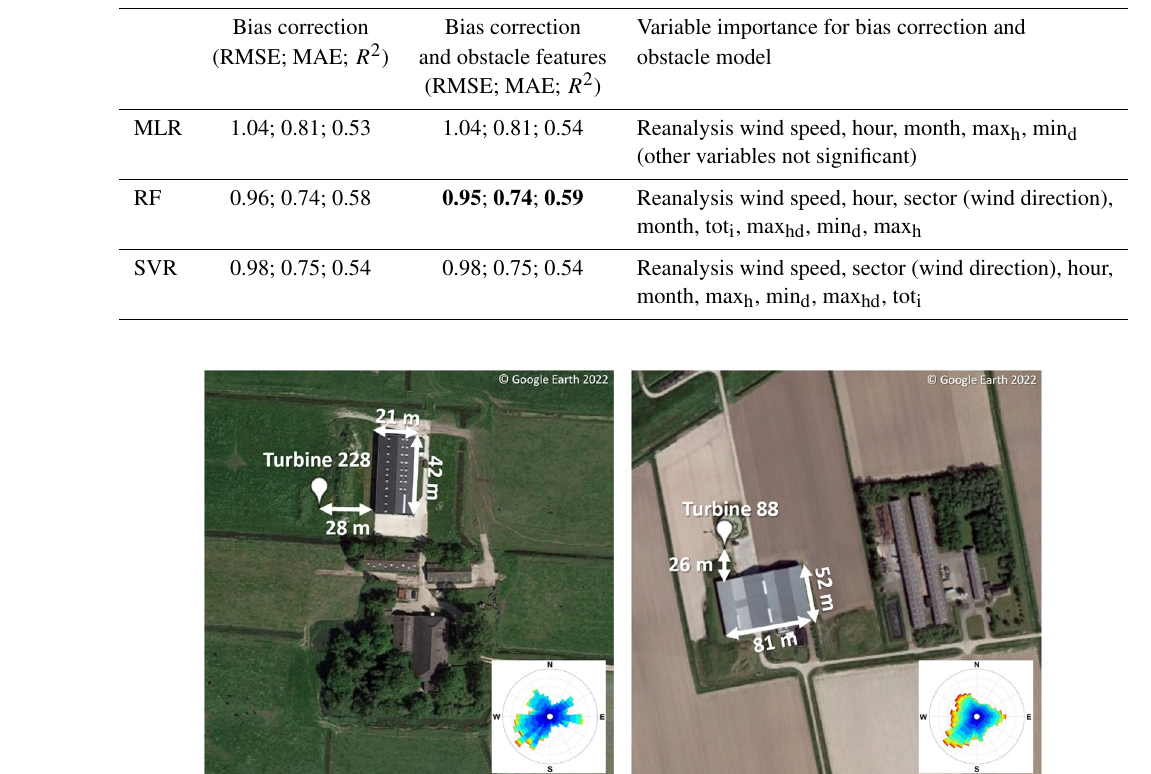
Table 3. Variable importance and performance metrics for fitted models. Results for wind speed (ms − 1 ) are given. Results from models predicting power generation are similar. Bold values show the best performing result.